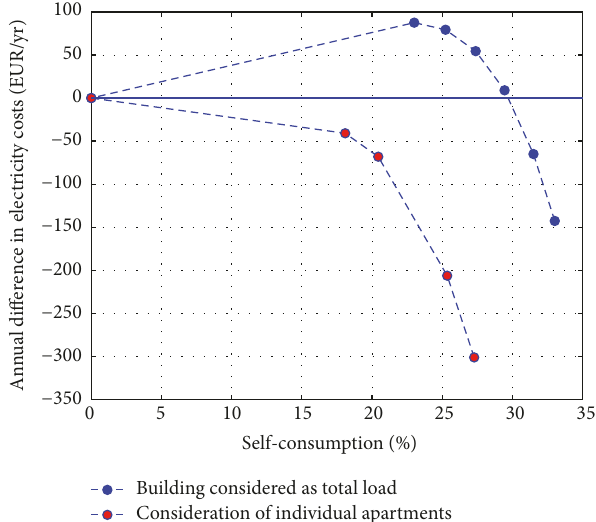
Figure 19: German retail electricity prices, comparison between buildings considered as total load and consideration of individual apartments’ load profiles: annual differences in electricity costs with and without a PV system.